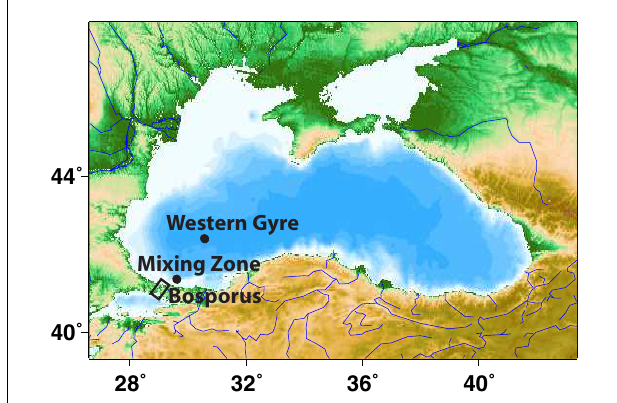
FIGURE 1 |A map of the Black Sea indicating the stations sampled in this study. This map was made with Map-It (http://woodshole.er.usgs.